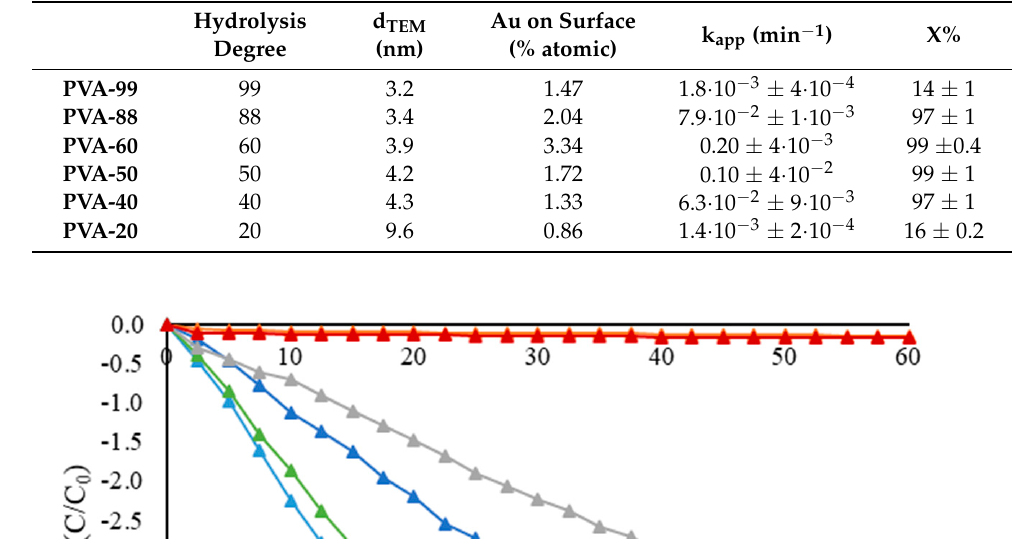
Table 10. Values of the apparent kinetic constant and conversion for pseudo-first-order reactions using PVA with different hydrolysis degrees.